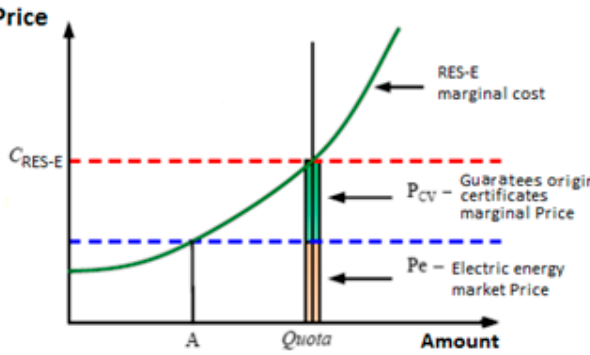
Figure 2. Working principle of a green certificate system, adapted from [15].